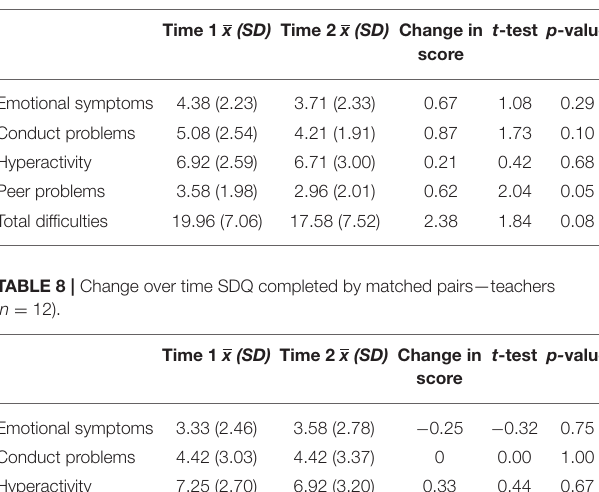
TABLE 7 | Change over time SDQ completed by matched pairs—carers ( n = 24).